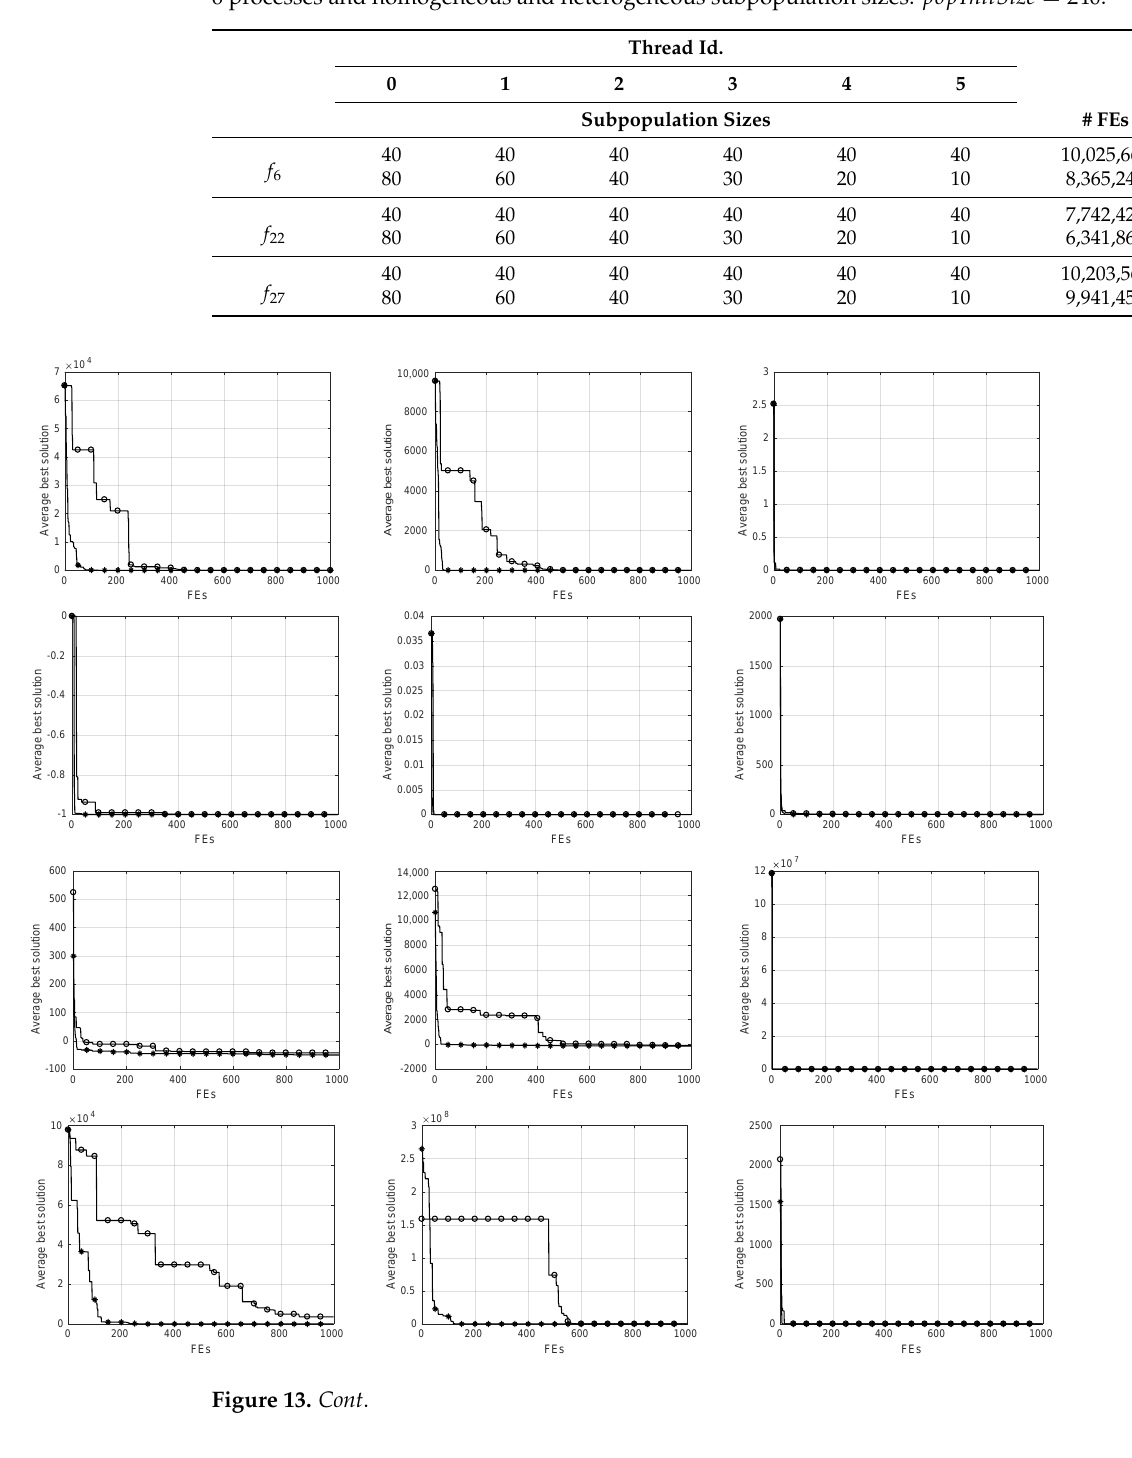
Table 13. Asynchronous parallel algorithm: number of function evaluations for error <1 × 10 − 3 , 6 processes and homogeneous and heterogeneous subpopulation sizes. popInitSize = 240.